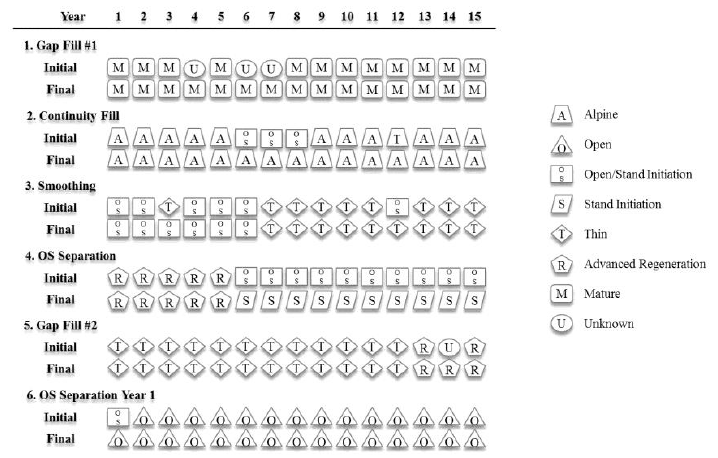
Figure 3. Examples of temporal continuity rules applied to a variety of 15-year time series. There were eight temporal continuity rules applied to the time series in order to improve accuracy and separate difficult to distinguish classes such as Open versus Stand Initiation: (1) Gap fill #1, (2) Continuity fill, (3) Smoothing, (4) Separate Open from Stand Initiation, (5) Gap fill #2, (6) Separate Open from Stand Initiation Year 1, (7) Alpine based on elevation, and (8) Non-forest based on elevation (each rule is